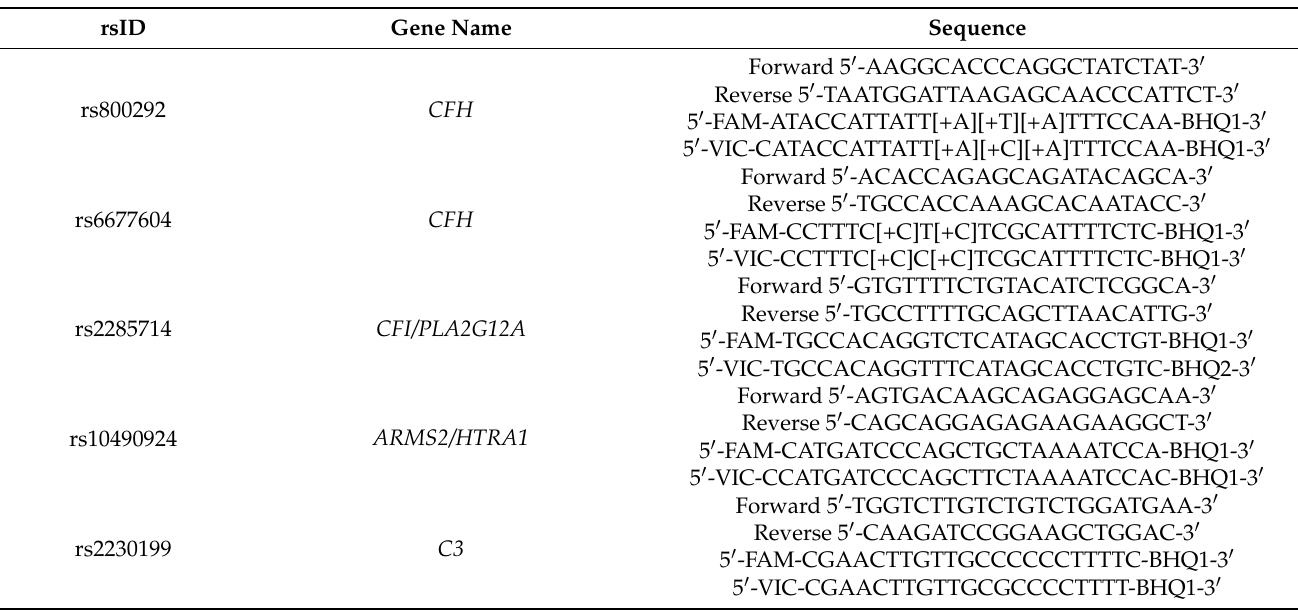
Table 2. Primer/probe